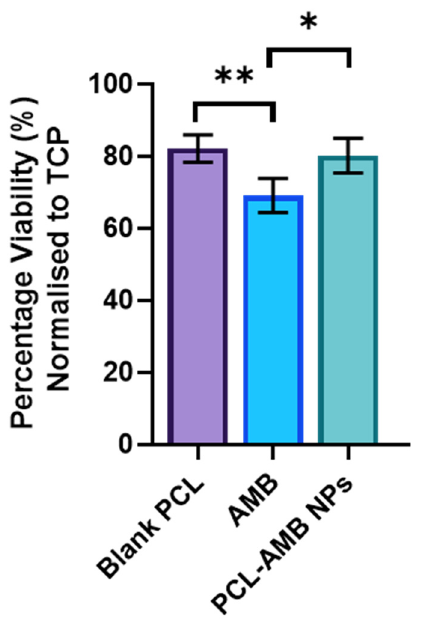
Figure 6. Viability of human dermal fibroblasts treated with PCL NPs, AMB, and PCL-AMP NPs at 1 × MIC, using MTT assay post 48 h treatment normalized to TCP, mean ± SD, n = 3, * p < 0.05 and ** p < 0.001.